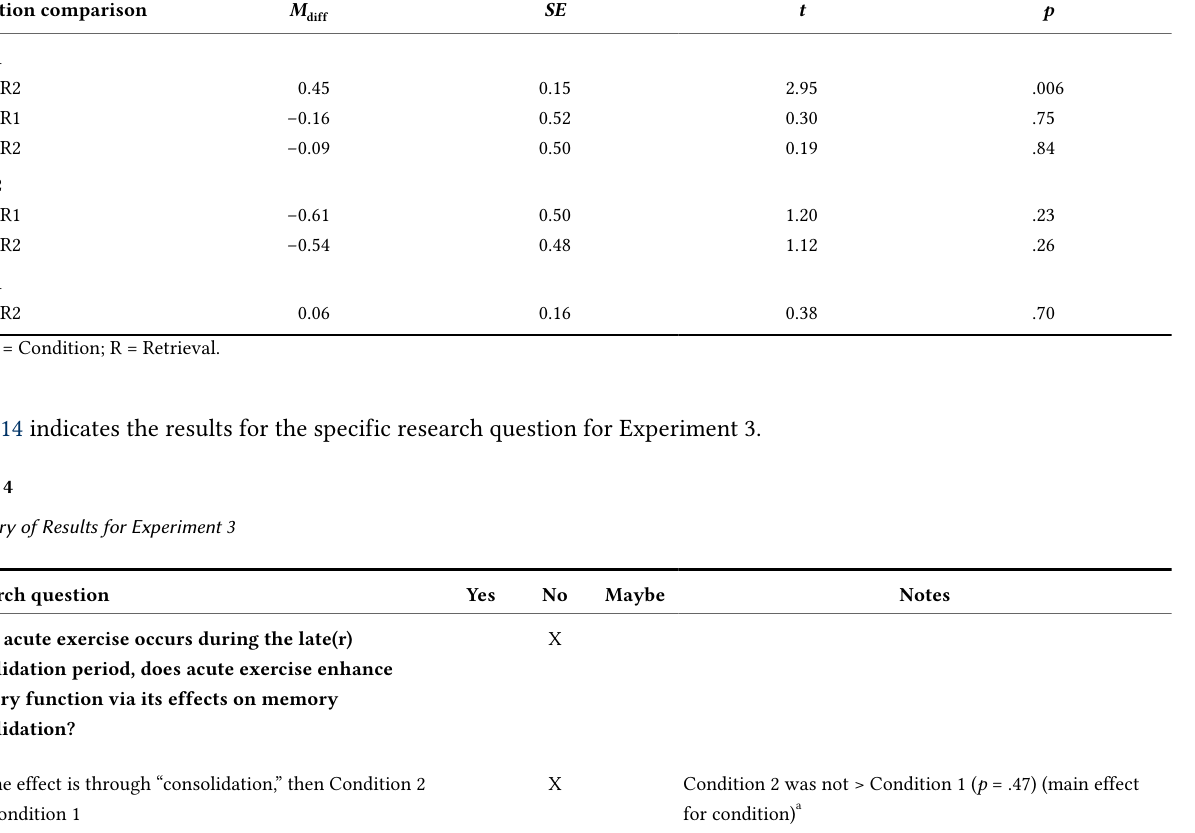
Post-Hoc Results Comparing the Memory Results Across the Experimental Conditions (Results Evaluated Across Condition and Time Period)